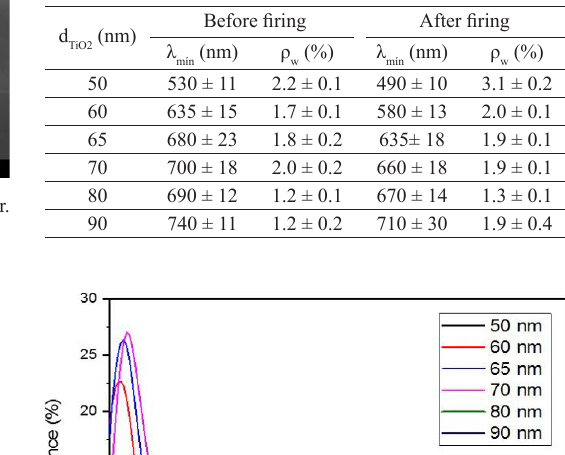
2 is the thin film thickness TiO2